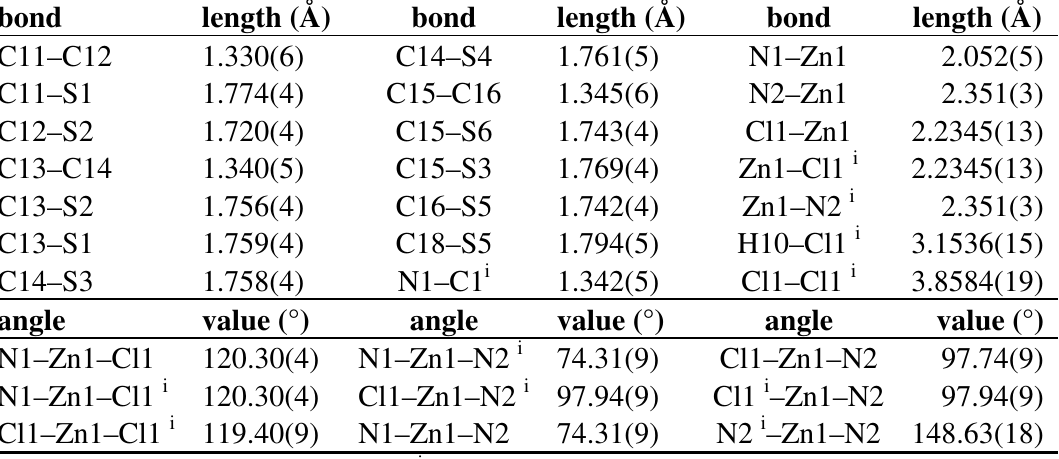
Table 1. Selected bond lengths (Å) and angles (°) for compound 4 .